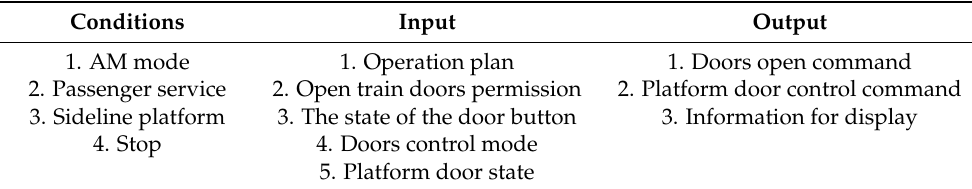
Table 5. System requirement parameters in the